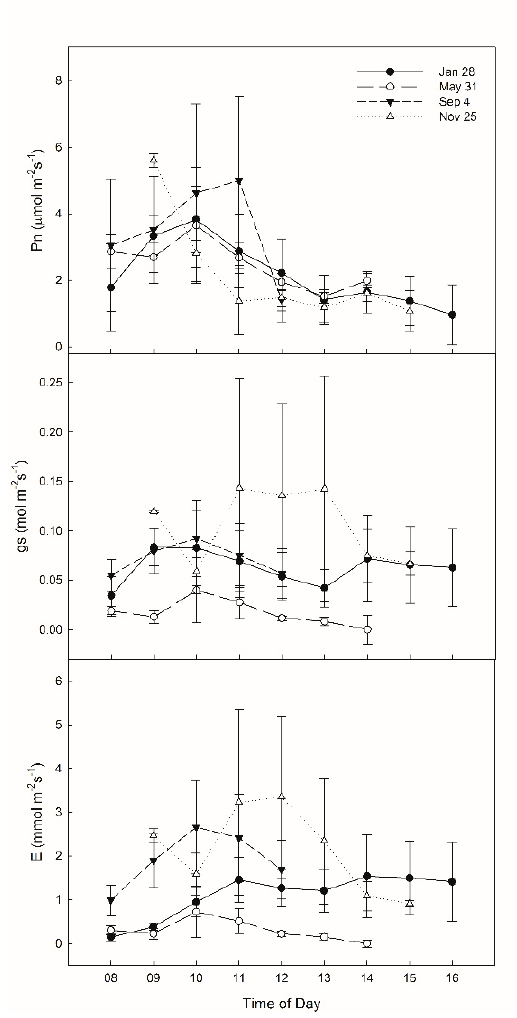
Figure 3. Diurnal variation of net photosynthetic rate ( P n ), stomata conductance (g s ), and transpi- ration rate (E) on 28 January, 31 May, 4 September, and 25 November, 2011. N = 3, bars indicate ± standard error.